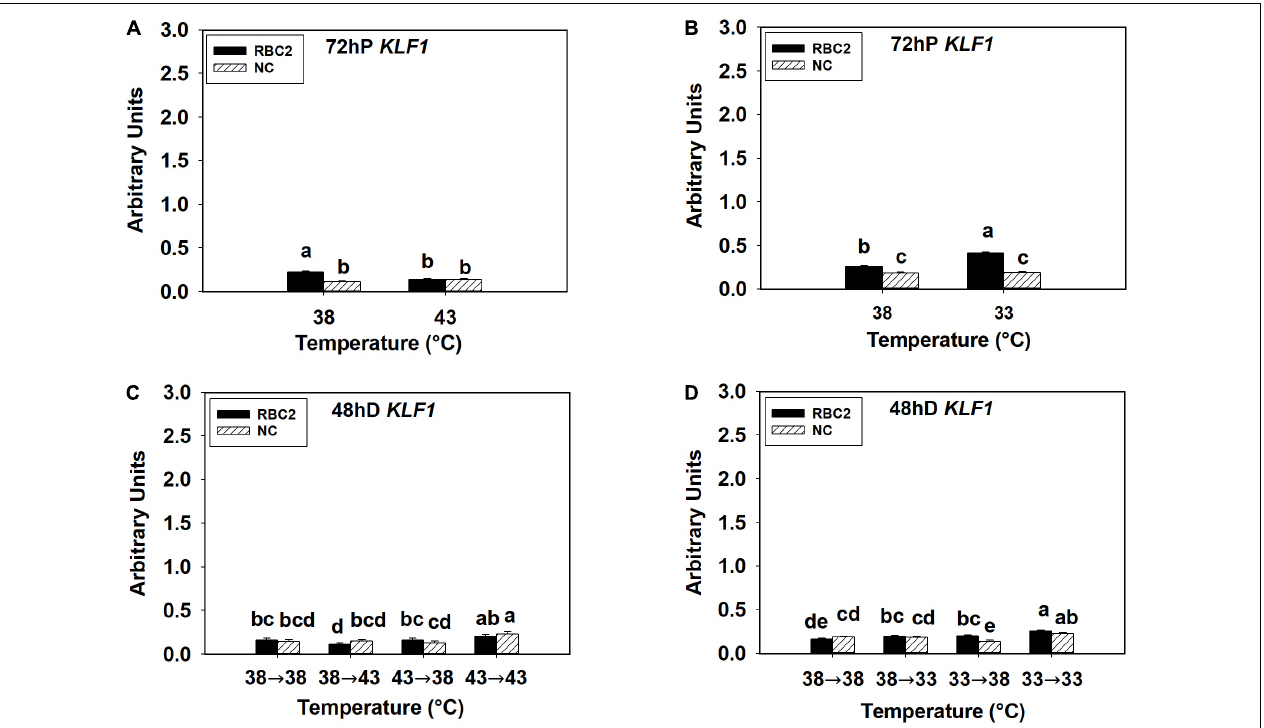
FIGURE 4 | Expression of kruppel like factor 1 ( KLF1 ) at 72 h of proliferation (72 hP) and 48 h of differentiation (48 hD) in satellite cells isolated from the pectoralis major (p. major) muscle of 7-day-old Randombred Control Line 2 (RBC2) and 7-day-old Nicholas Commercial (NC) turkeys. (A) Satellite cell proliferation at 38 ◦ or 43 ◦ C for 72 h. (B) Satellite cell proliferation at 38 ◦ or 33 ◦ C for 72 h. (C) Satellite cell proliferation for 72 h and differentiation for 48 h, both at 38 ◦ C (38 ◦ → 38 ◦ C); proliferation at 38 ◦ C for 72 h and differentiation at 43 ◦ C for 48 h (38 ◦ → 43 ◦ C); proliferation at 43 ◦ C for 72 h and differentiation at 38 ◦ C for 48 h (43 ◦ → 38 ◦ C); or proliferation for 72 h and differentiation for 48 h, both at 43 ◦ C (43 ◦ → 43 ◦ C). (D) Satellite cell proliferation for 72 h and differentiation for 48 h, both at 38 ◦ C (38 ◦ → 38 ◦ C); proliferation at 38 ◦ C for 72 h and differentiation at 33 ◦ C for 48 h (38 ◦ → 33 ◦ C); proliferation at 33 ◦ C for 72 h and differentiation at 38 ◦ C for 48 h (33 ◦ → 38 ◦ C); or proliferation for 72 h and differentiation for 48 h, both at 33 ◦ C (33 ◦ → 33 ◦ C). Each graph bar represents a mean arbitrary unit, and each error bar represents a standard error of the mean. Mean values without a same letter were significantly different ( P ≤